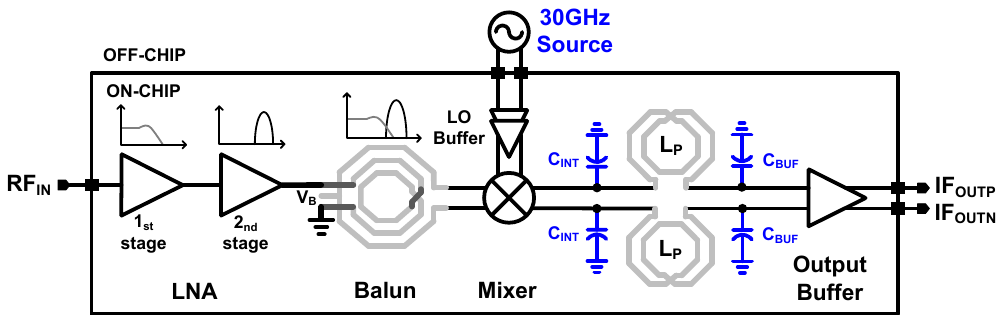
Figure 1. Receiver front-end architecture: stagger-tuned two-stage low noise amplifier (LNA), down-conversion mixer loaded with 3-stage LC ladder filter, LO buffer, and output